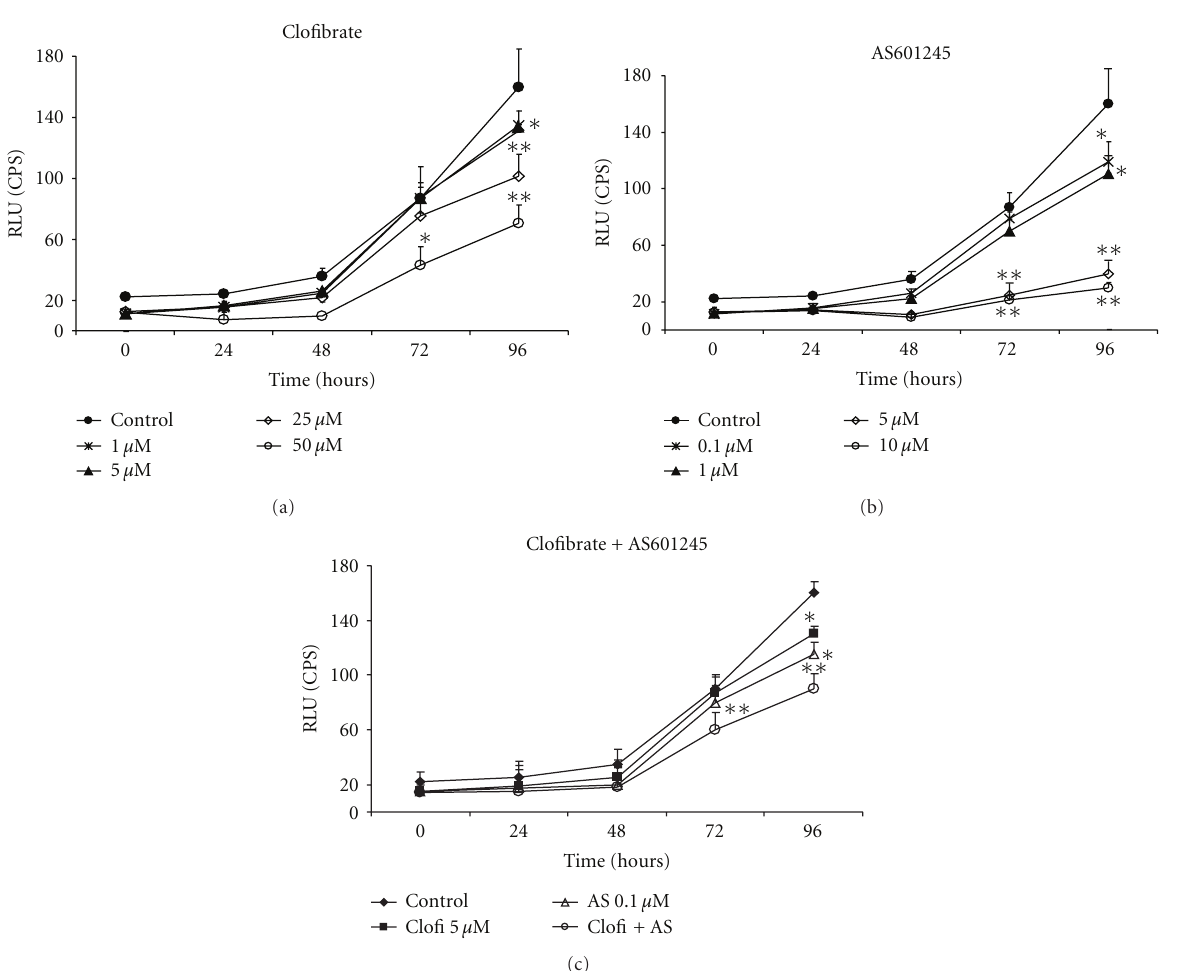
(6.5-fold change). AP3D1 was increased (3.6-fold change)